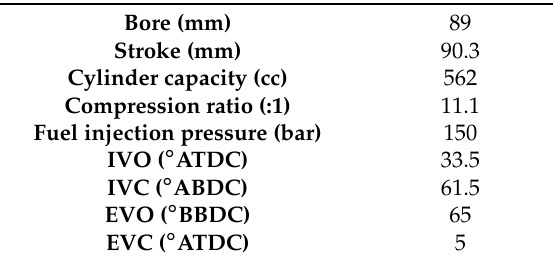
Table 8. Single-cylinder DI engine specifications. IVO = intake valve opens; IVC = intake valve closes; EVO = exhaust valve opens; EVC = exhaust valve closes; ATDC = after top dead center; ABDC = after bottom dead center; BBDC = before bottom dead center.